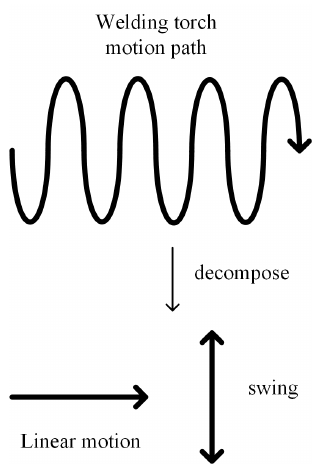
Figure 9. Decomposition of welding torch path.